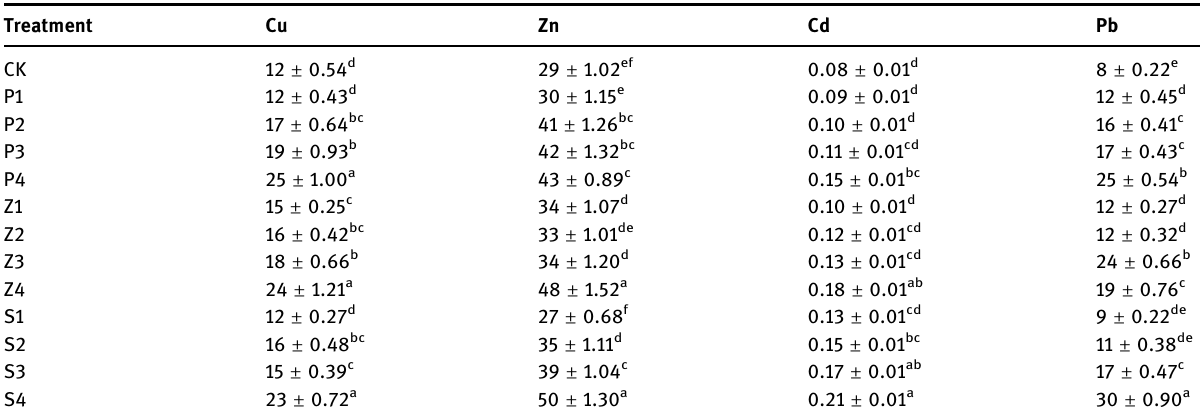
Table 2: E ff ects of di ff erent passivators on the concentrations of residual heavy metals ( mg/kg ) in soil